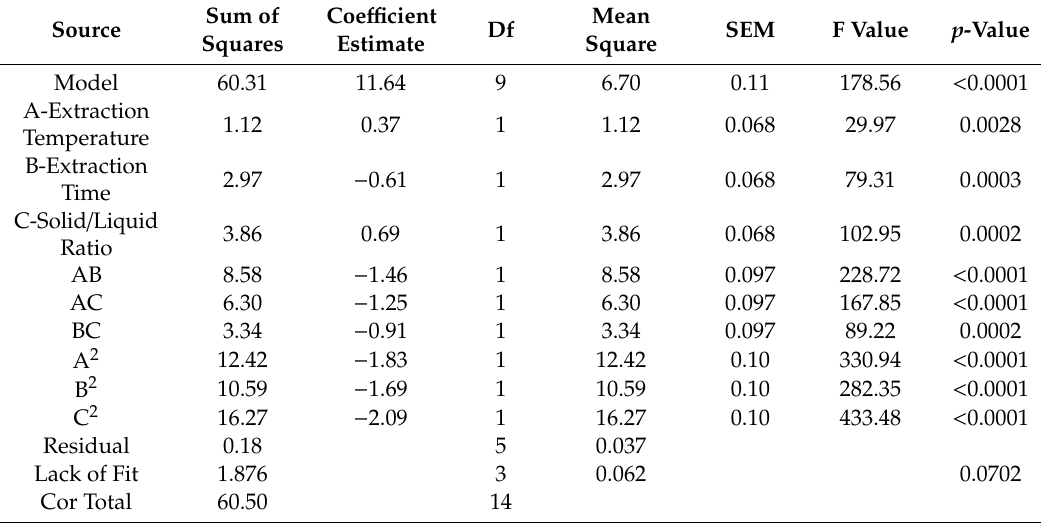
Table 3. Analysis of the variance and regression coe ffi cients of the calculated surface quadratic model polysaccharide